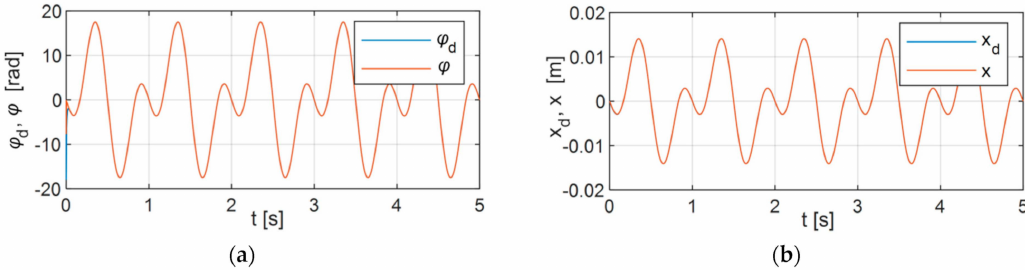
Figure 4. Trajectory: ( a ) adjusted ϕ d and realized ϕ positions of the active part; ( b ) adjusted x d and realized x positions of the passive part.